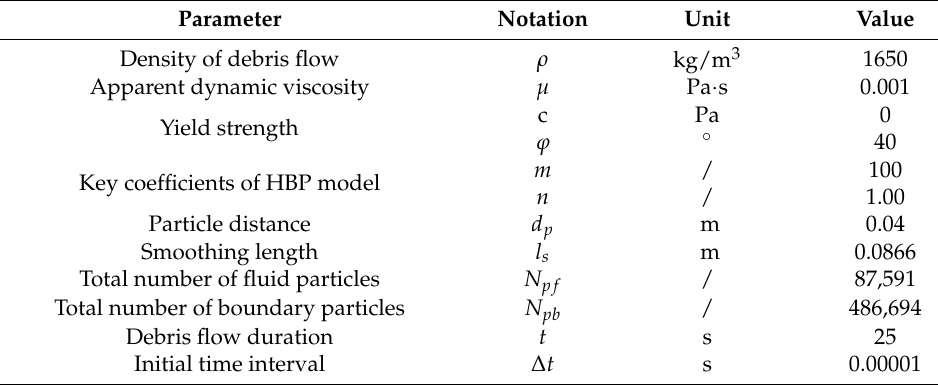
Table 1. Key parameter of numerical simulation.